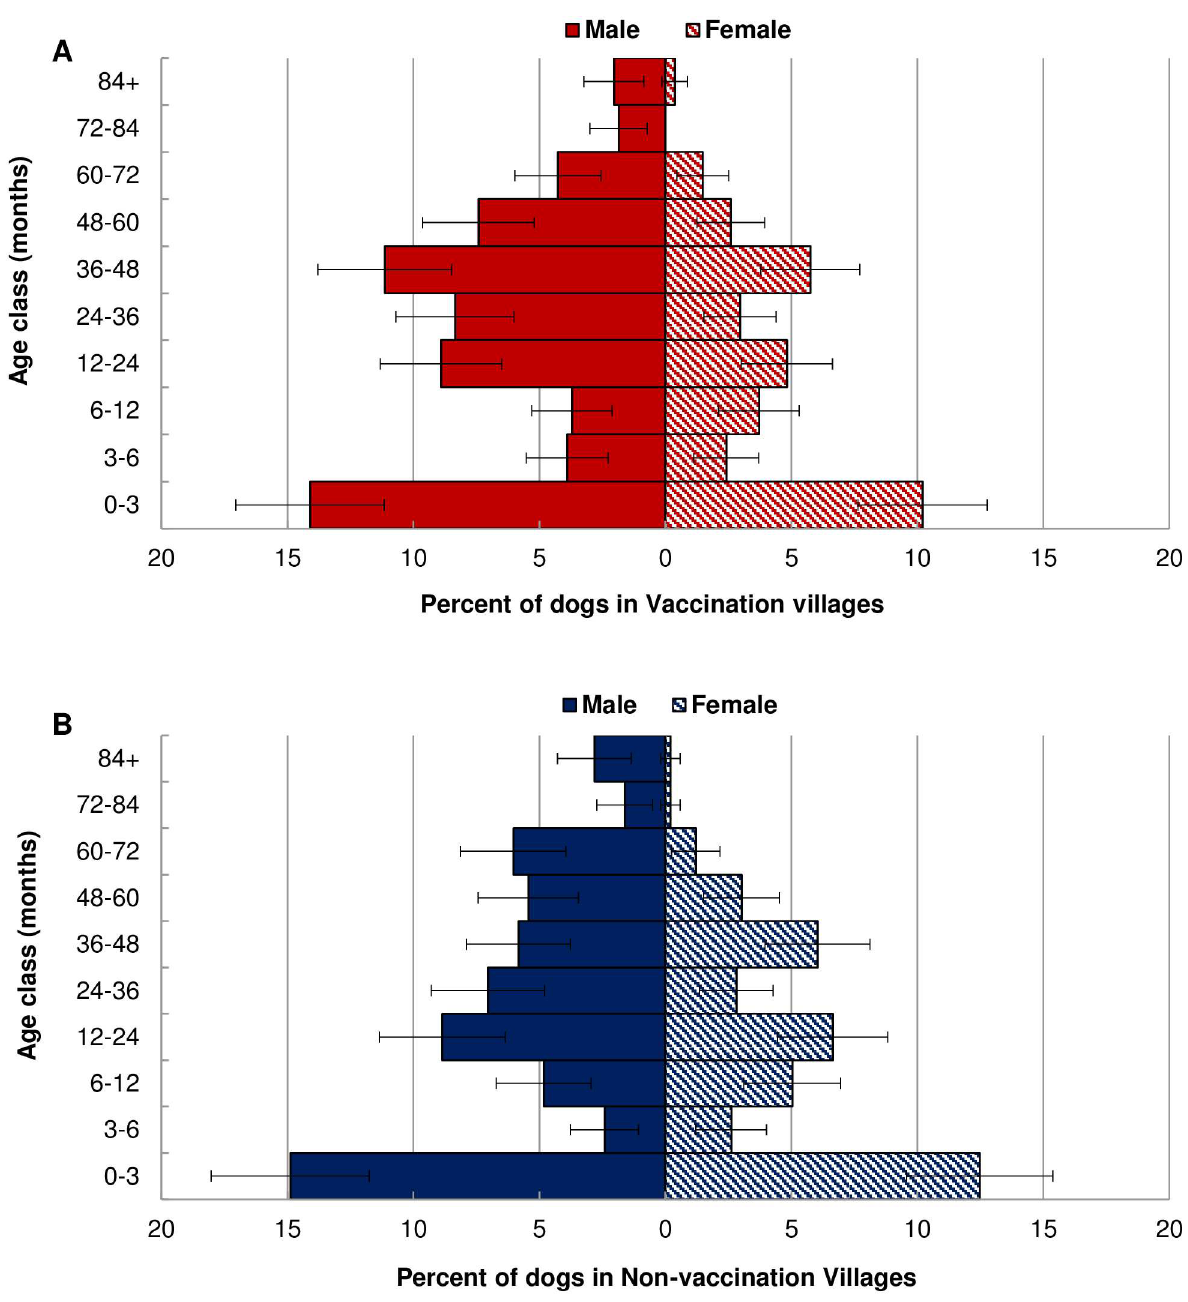
Fig 2. Age and sex distribution of dogs alive in 2013 ( n = 1,028). Percent of males (solid bars) and females (hashedbars) in each age class (months). Red bars (A) indicate vaccination villagedogs and bluebars (B) indicatenon-vaccination control villagedogs. Error bars indicate95%